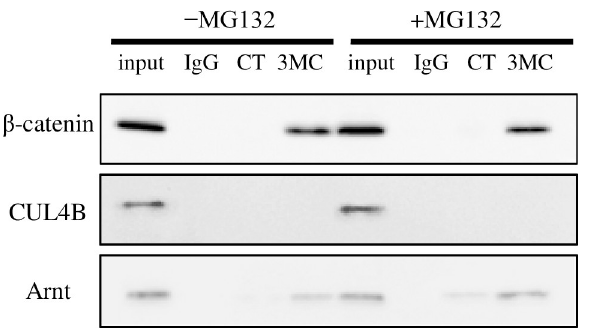
Fig 8. Coimmunoprecipitation of β -catenin or CUL4B with an AhR antibody. Wild-type β -catenin expression vectors pCI- β cat and pCI-mAhR were cotransfected into HCT116 cells, and the transfected cells were exposed to 1 µ M 3MC (3MC) or DMSO (CT, solvent control) with or without 100 μ M MG-132 for 2 h. Nuclear lysates were extracted and coimmunoprecipitated by AhR-specific antibodies. Immunoprecipitated fractions were analyzed by SDS–PAGE and immunoblotting using specific antibodies for β -catenin (upper panel), CUL4B (middle panel), or Arnt (lower panel). Input (Lane 1 and 5) represents 1/20 of the lysates from cells treated with 3MC presence or absence of MG-132. As a negative control, immunoprecipitation was performed using control (non-specific) IgG (lane2 and 6, IgG).